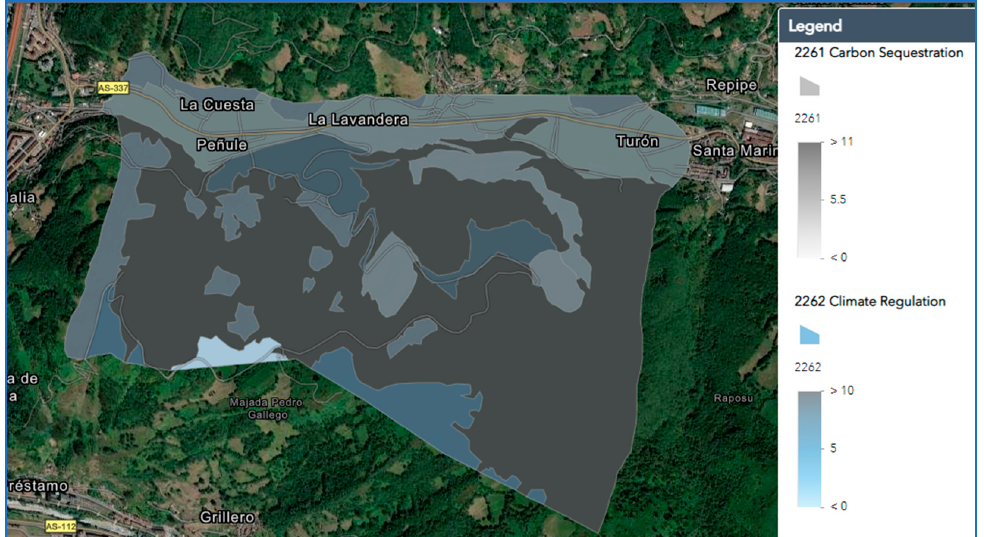
Figure 2. ArcGIS Online of the Figaredo mine area.